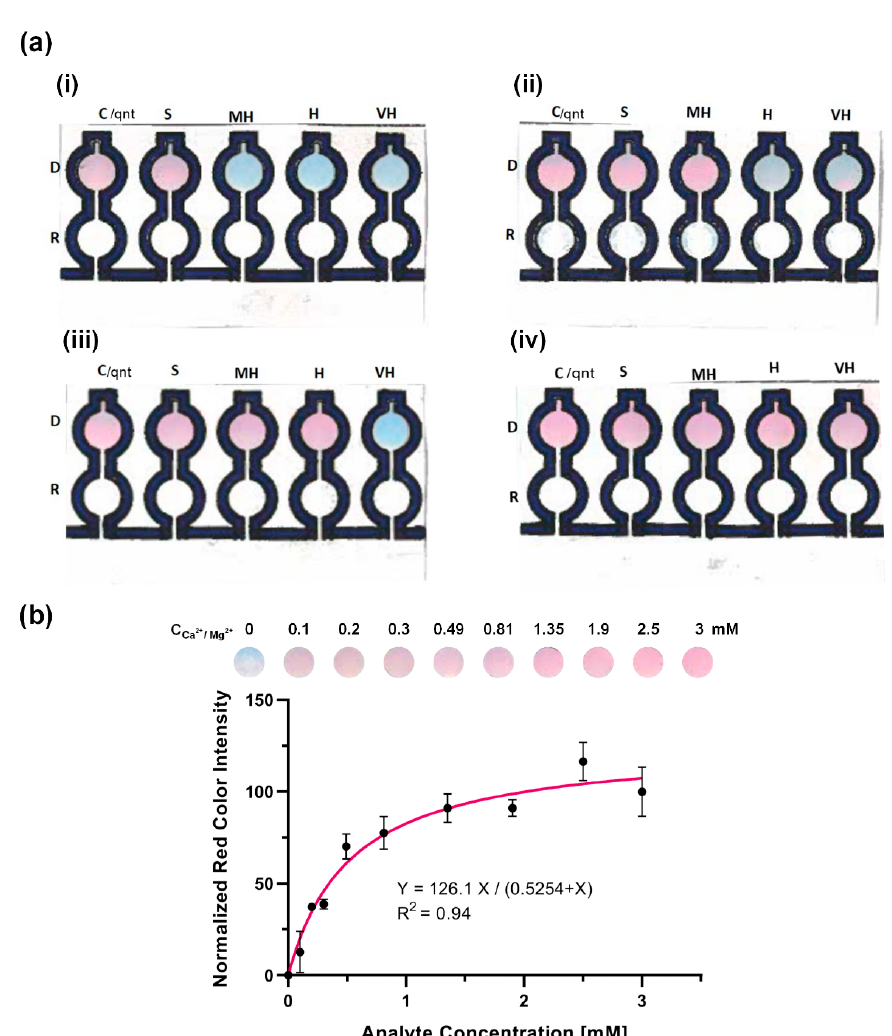
Figure 6. Qualitative and quantitative detection of the total hardness of water. ( a ) Qualitative detection of the total hardness of spiked samples of ( i ) soft water as in 0.49 mM equivalent CaCO 3 concentration, ( ii ) moderately hard water as in 0.81 mM equivalent CaCO 3 concentration, ( iii ) hard water as in 1.35 mM equivalent CaCO 3 concentration, and ( iv ) very hard water as in 2.5 mM equivalent CaCO 3 concentration. ( b ) Calibration curve for quantitative analysis using the paper-based analytical device. The control detection zone of the device changed from blue to pink in ~3 min in correspondence with different concentrations of the CaCO 3 equivalent to the total hardness of water. In the graph, the black data points represent the normalized average red color intensities of the control detection zone of the device at each concentration obtained by the ImageJ software after scanning. Each point is the mean of the three individual experiments at each concentration ± standard deviation. The solid line illustrates the best fitted Michaelis–Menten equation to the